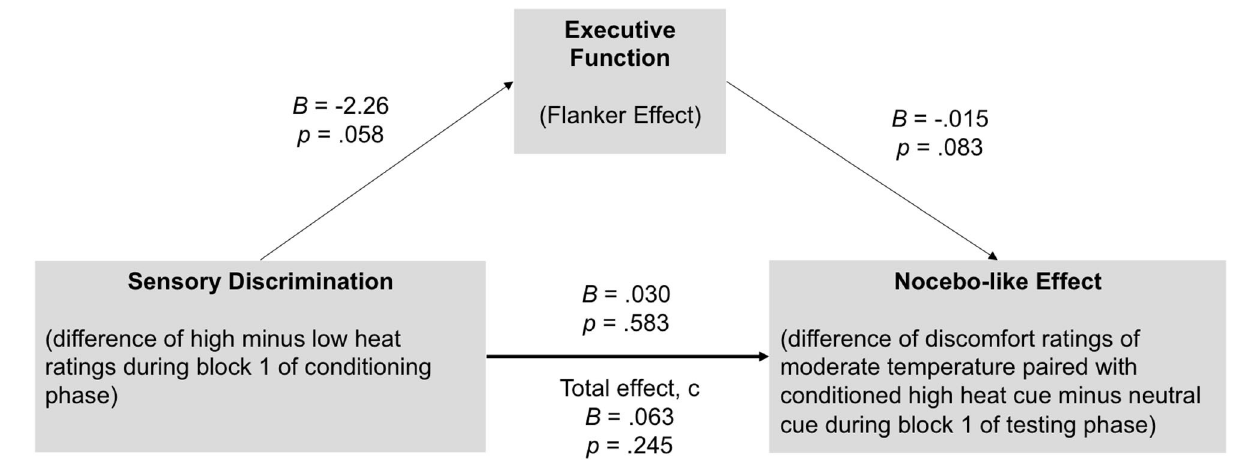
FIGURE 5 | Executive function (Flanker effect) mediates the association between sensory discrimination and the nocebo-like effect in youth. There was a significant : : indirect effect of sensory discrimination Flanker effect nocebo-like effect, B = 0.033 (0.028) 95% CI [0.006–0.1173], suggesting that executive function partially explain the association between sensory discrimination and the magnitude of the nocebo-like effect. Unstandardized